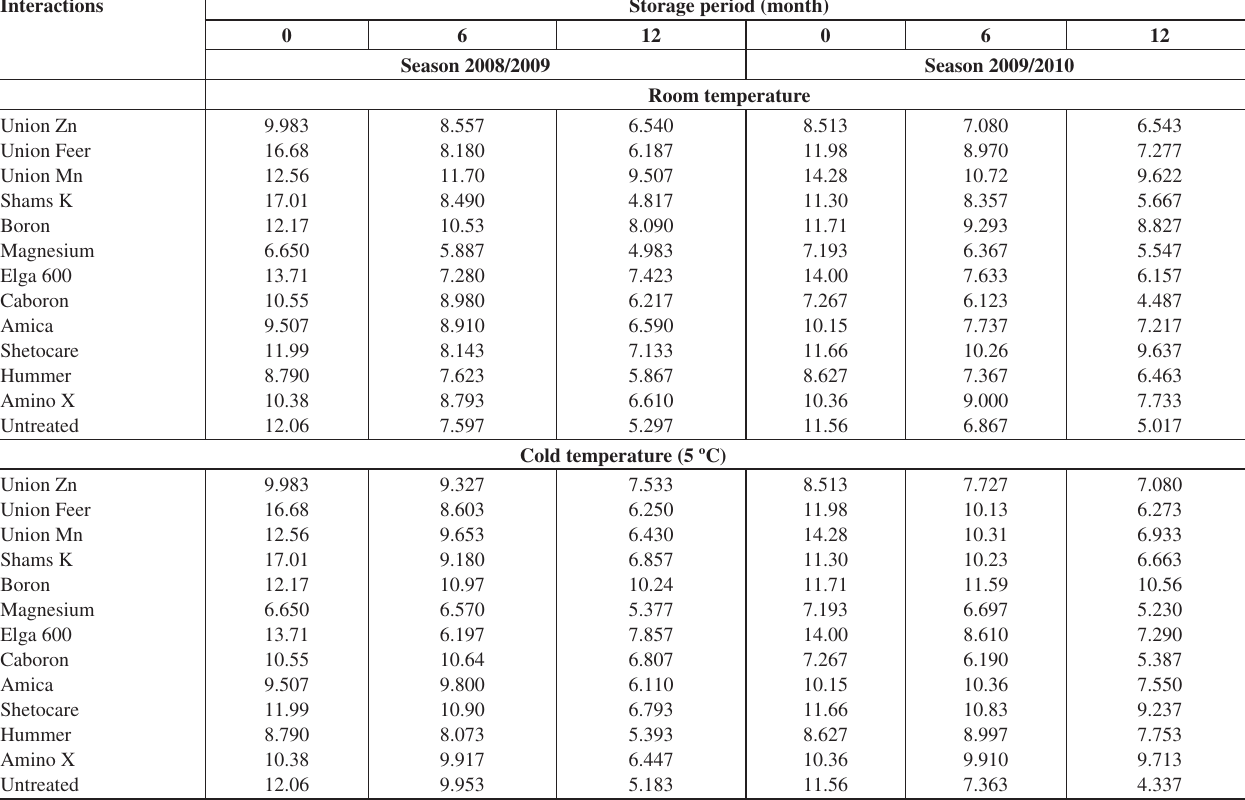
Table 22: Effect of the interaction between storage temperature, storage period and foliar application with commercial compounds on peroxidase activity of onion seeds during seasons of 2008/2009 and 2009/2010 Interactions